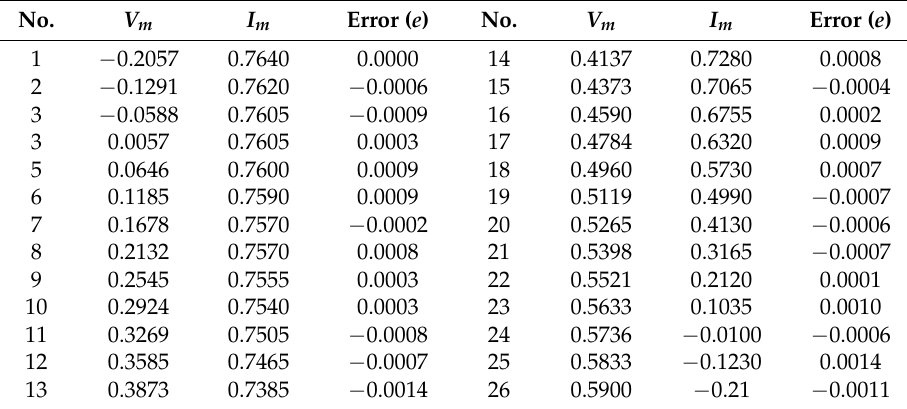
Table 7. Relative error respective to each measurement for single diode PV model.